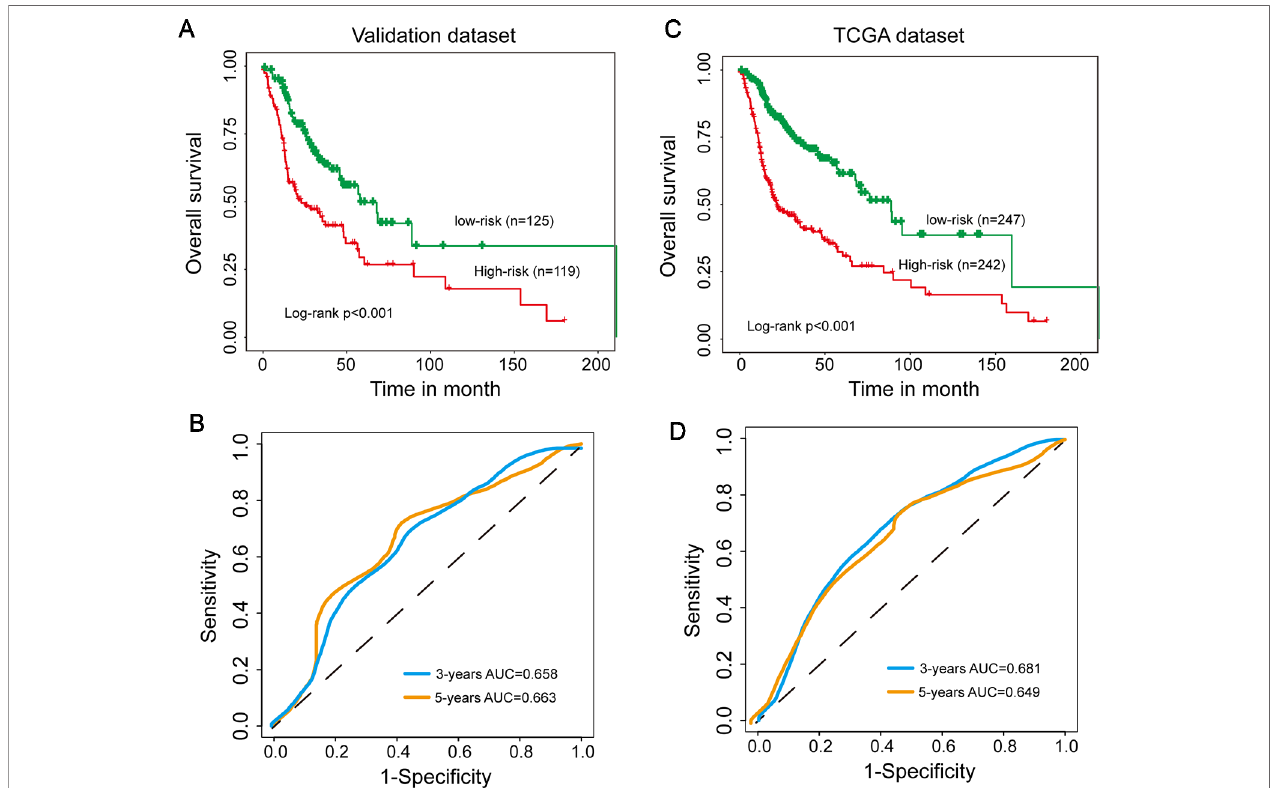
FIGURE 3 | Independent validation of the 15SigRS in the Cancer Genome Atlas (TCGA) data set. (A) Kaplan – Meier survival curves of overall survival between the high- risk group and low-risk group in the validation data set. (B) Time-dependent ROC analysis at 3 and 5 years in the validation data set. (C) Kaplan – Meier survival curves of overall survival between the high-risk group and low-risk group in the TCGA data set. (D) Time-dependent ROC analysis at 3 and 5 years in the TCGA data